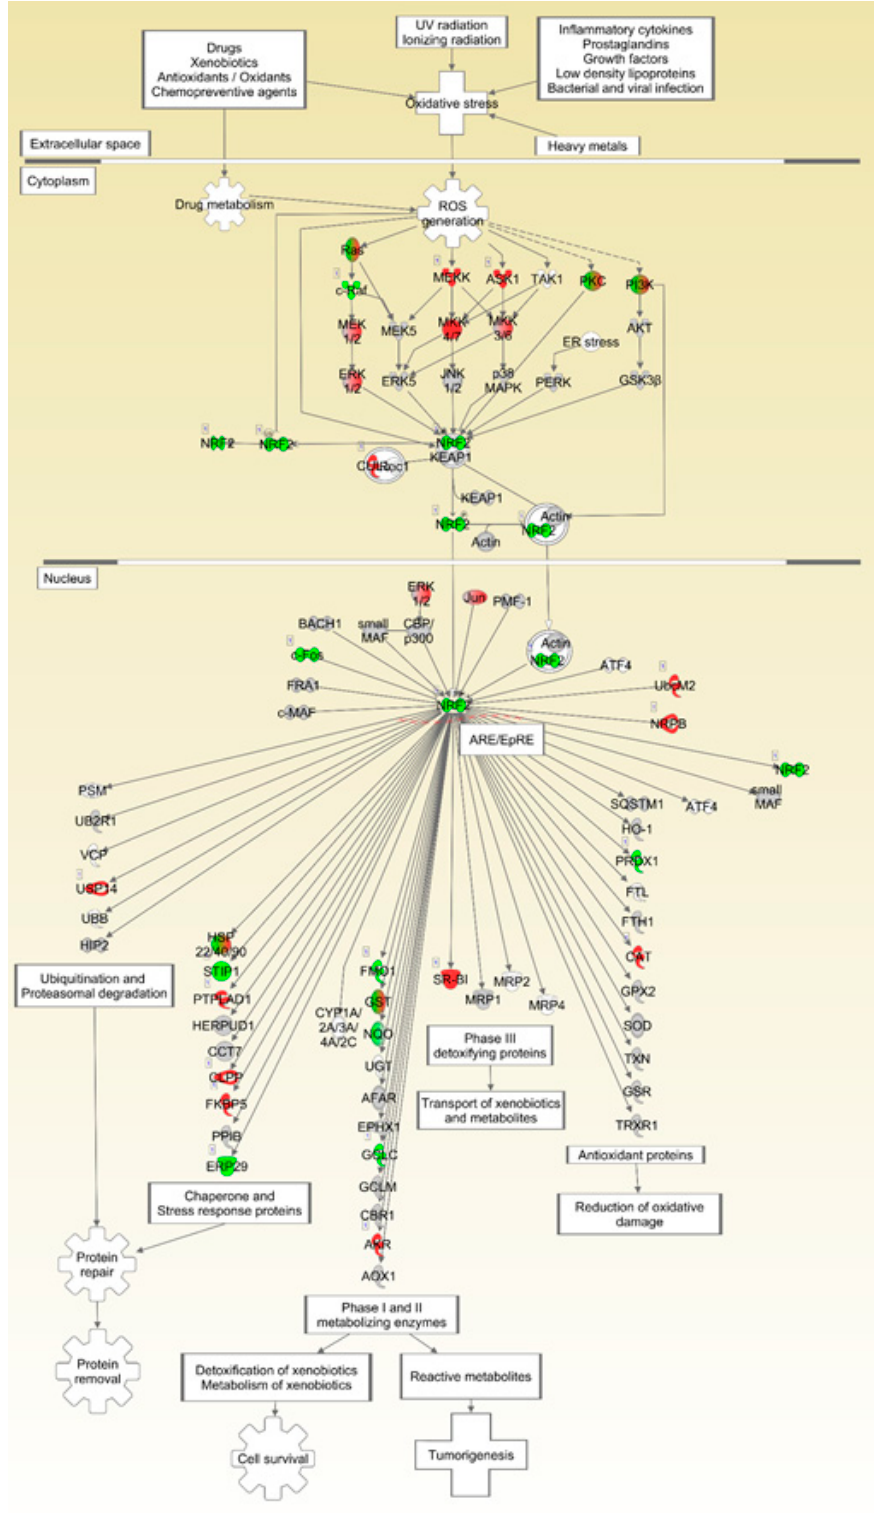
Figure 9. NFE2L2/NRF2-mediated pathways are downregulated in spaceflight mouse livers. Ingenuity Pathway Analysis was used for analysis of mRNA transcript levels in livers from FLT and AEM control mice. Grey = unchanged, green = downregulated, red = upregulated. Intensity of color correlates with degree of fold-change. n = 6/group.